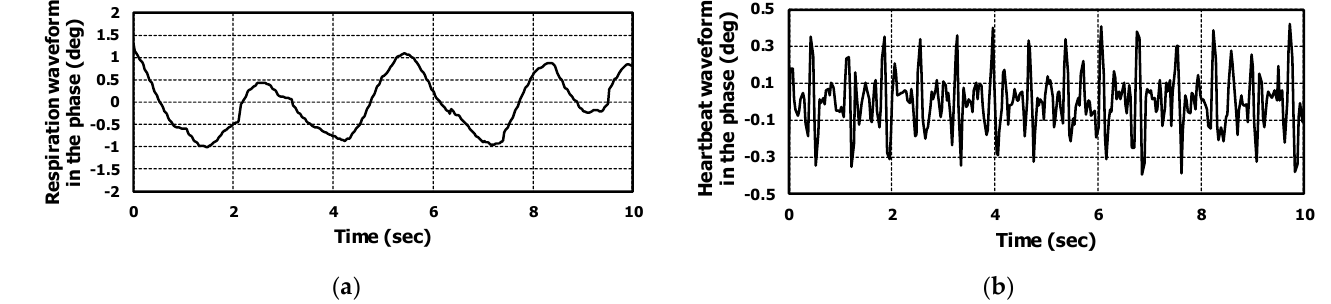
Figure 10. The extracted waveform of ( a ) respiration and ( b ) heartbeat from measured raw data of radar.